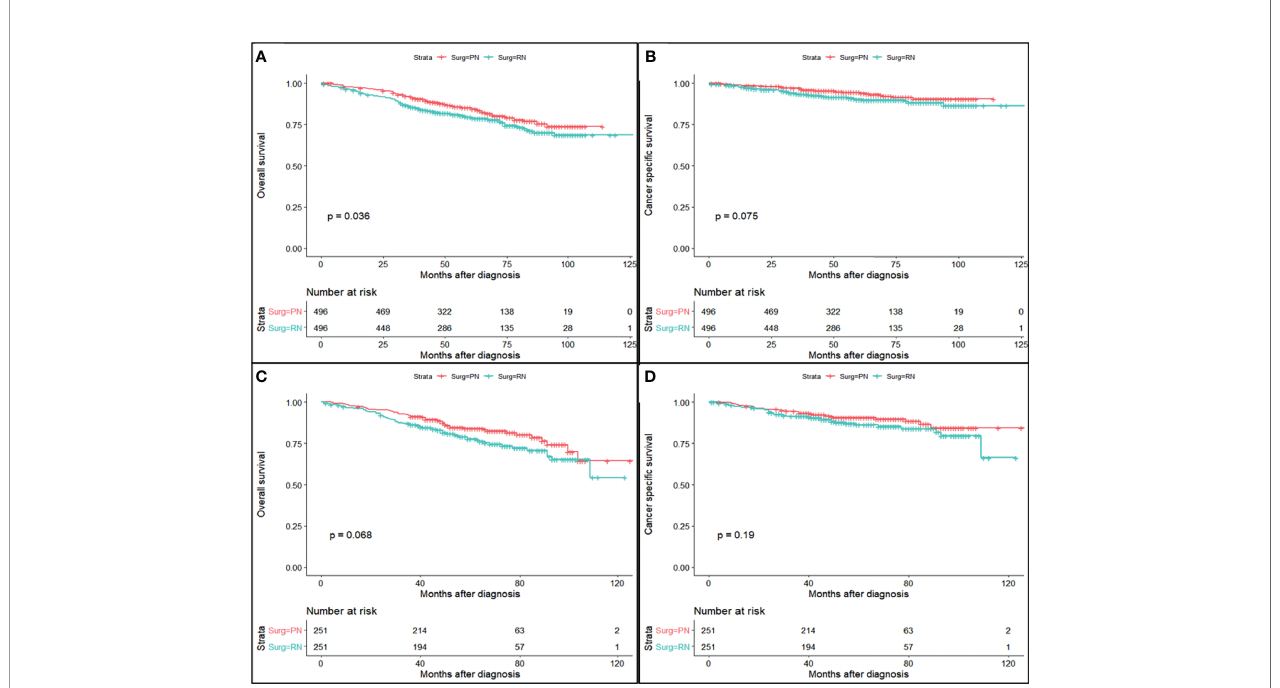
FIGURE 2 | Survival curve of partial nephrectomy (PN) and radical nephrectomy (RN) group in fat invasion cohort and venous invasion cohort after propensity score matching (PSM). (A) Overall survival (OS) curve of fat invasion cohort. (B) Cause-speci fi c survival (CSS) curve of fat invasion cohort. (C) OS curve of venous invasion cohort. (D) CSS curve of venous invasion